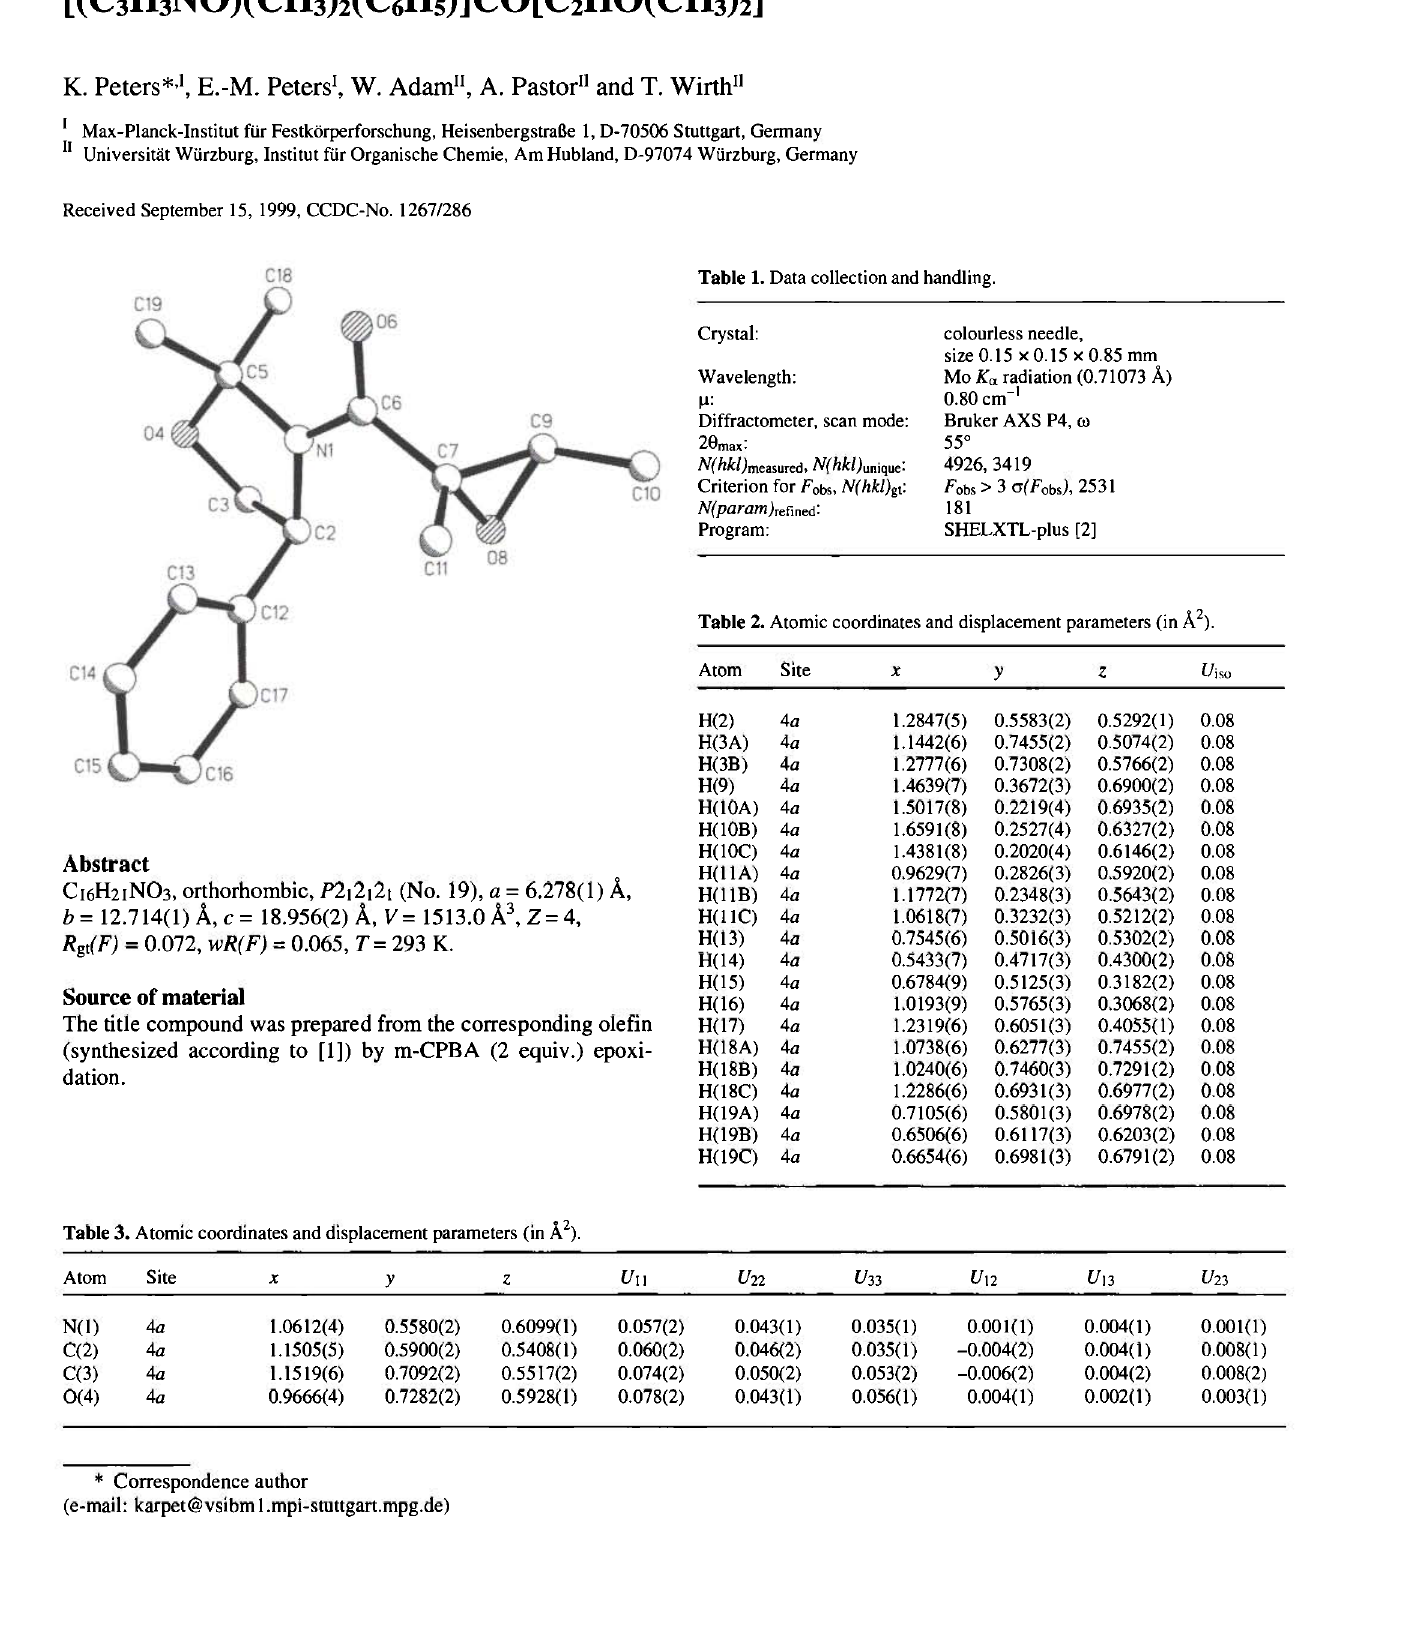
Table 3. Atomic coordinates and displacement parameters (in A 2